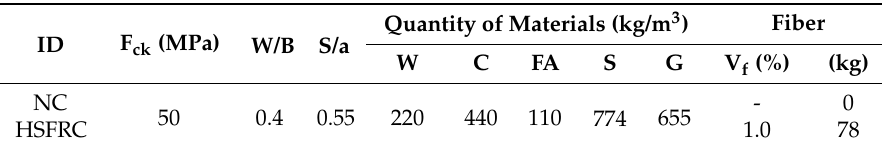
Table 3. Details of concrete mixes.